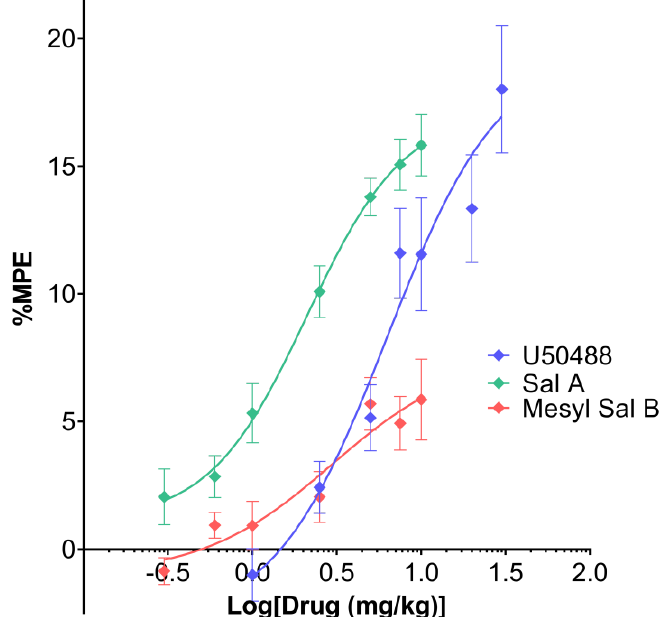
Figure 3. The effects of Mesyl Sal B on 50 ◦ C warm-water tail withdrawal in mice showing cumulative dose-response effects. Non-linear regression analysis showed that a different curve fit each data set (F(6,93) = 14.43, p < 0.0001). Mesyl Sal B (EC 50 = 3.0 mg/kg, E max = 38% of U50488) exerts only partial antinociceptive effects in the tail withdrawal compared to both Sal A (EC 50 = 2.1 mg/kg, E max = 87% of U50488) and U50488 (EC 50 = 6.7 mg/kg, E max = 19.7 mg/kg). Data presented as mean ± SEM; n = 6 for